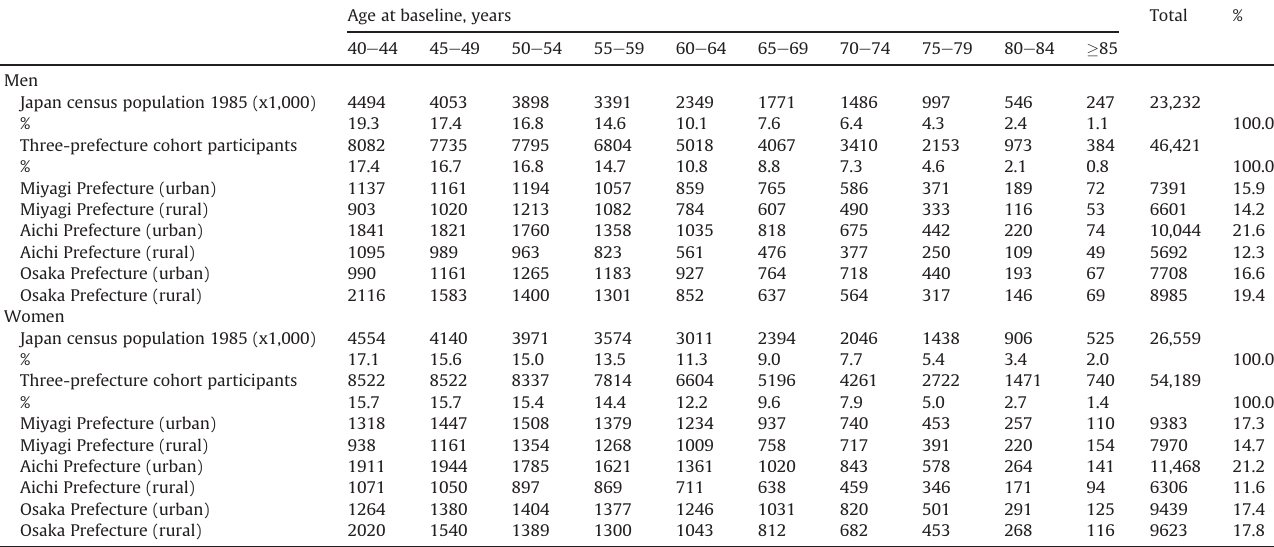
Table 2 Distribution of cohort participants at baseline by gender, age, and